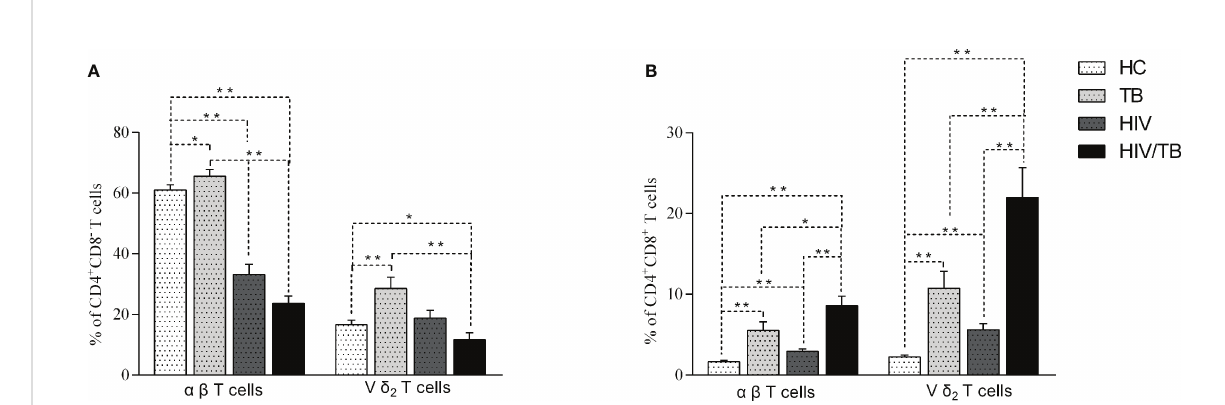
FIGURE 2 Comparison of the CD4 + CD8 - (A) and CD4 + CD8 + (B) V d 2 subset and ab T cells in each group. P-value calculated using the Mann – Whitney U test. Statistically signi fi cant differences between the groups were indicated as follows: *P<0.05 and **P<0.01. Those that were not statistically signi fi cant were not marked intra group or inter